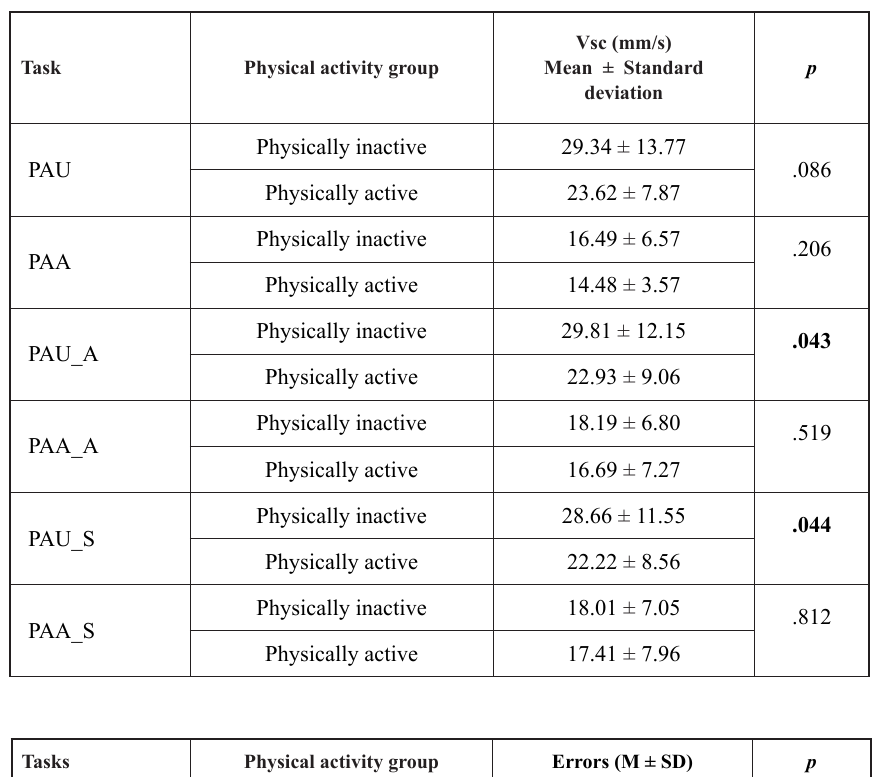
Table 2. Dual task effect on mo - tor functions insubjects in the aspect of their physical activity